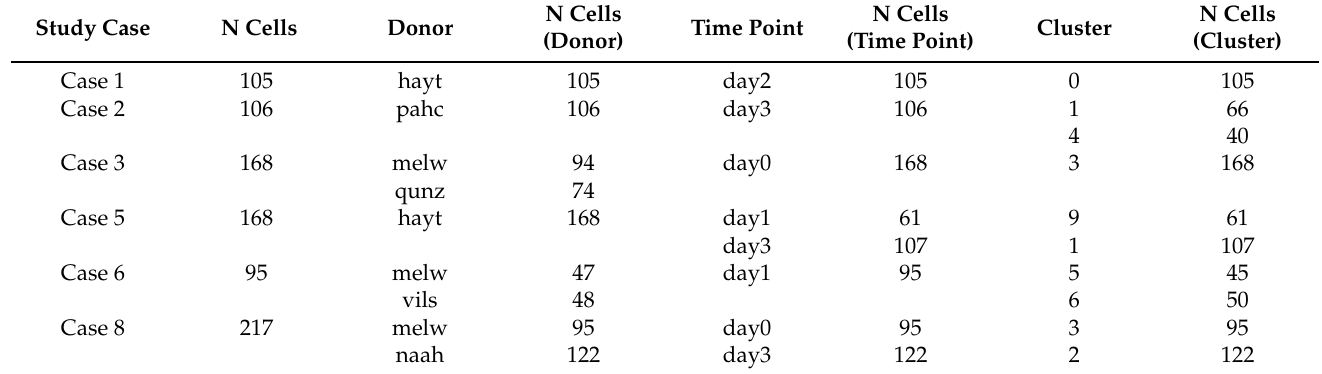
Table 1. Overview of the study cases built on scRNA-seq Smart-seq data (Cuomo et al., 2020, [42]) illustrating the combinations of the different covariates. Study case 4 (same donor, different time- point and same cluster) and case 7 (different donor, different time-point, and same cluster) could not be generated due to the data structure. While an insufficient number of cells fell into these two study cases (4 and 7) in this instance, they do represent valid study cases that should be considered for similar designs and are therefore still